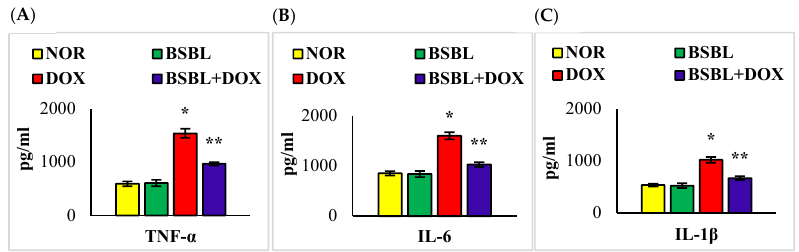
Figure 2. ( A – C ) Effect of α - Bisabolol on the levels of proinflammatory cytokines (TNF- α , IL-6, and IL-1 β ) in the kidney of normal and DOX-injected rats. DOX-injected rats showed a considerable ( p < 0.05) increase in the levels of proinflammatory cytokines in the kidney compared to normal control rats, while α -Bisabolol treatment showed a significant ( p < 0.05) decrease in the levels of proinflammatory cytokines in the kidney compared to DOX-alone treated rats. Each column is mean ± SEM for eight rats in each group; columns not sharing a common symbol (*, **) differ significantly with each other (* p < 0.05 vs. normal control, ** p < 0.05 vs. DOX control).